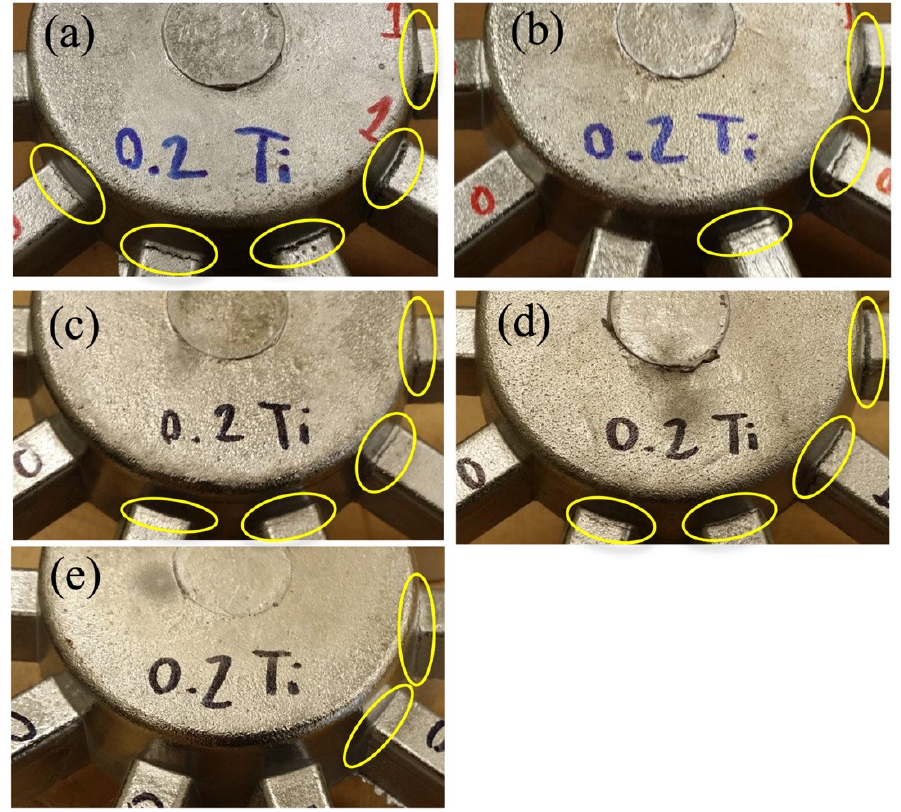
Figure 8. Pictures of representative multi-arm castings with 0.2 wt.% Ti addition: ( a ) DA1, ( b ) DA2, ( c ) DA5, ( d ) DA6, and ( e ) DA7.